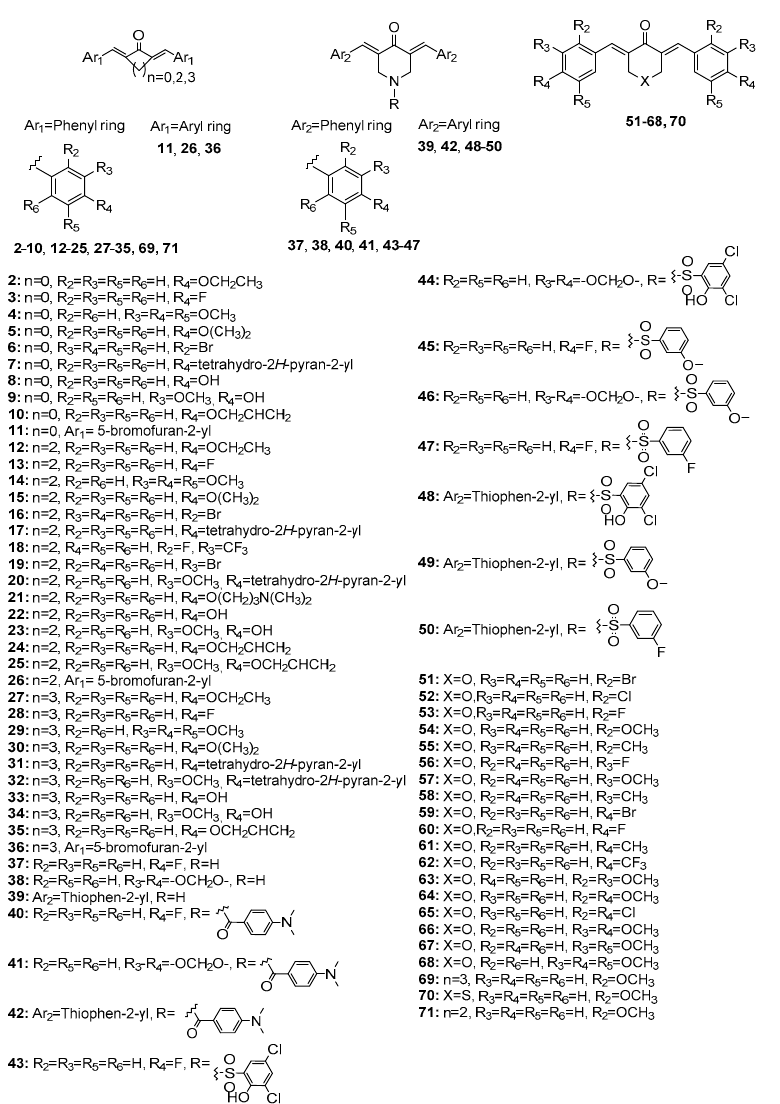
Molecules 2022 , 27 , x FOR PEER REVIEW Figure 3. Diarylpentanoids exhibiting antibacterial activity. Figure 3. Diarylpentanoids exhibiting antibacterial activity.